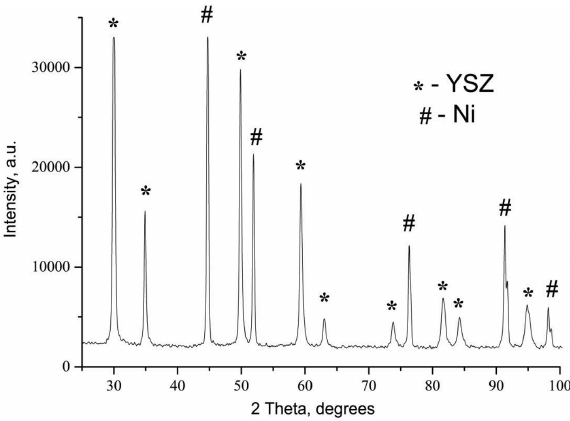
Figure 1: X-ray diffractogram of NiO/YSZ layer sintered in vacuum at a temperature of 1,200° С and a residual pressure of 1.33·10 – 3